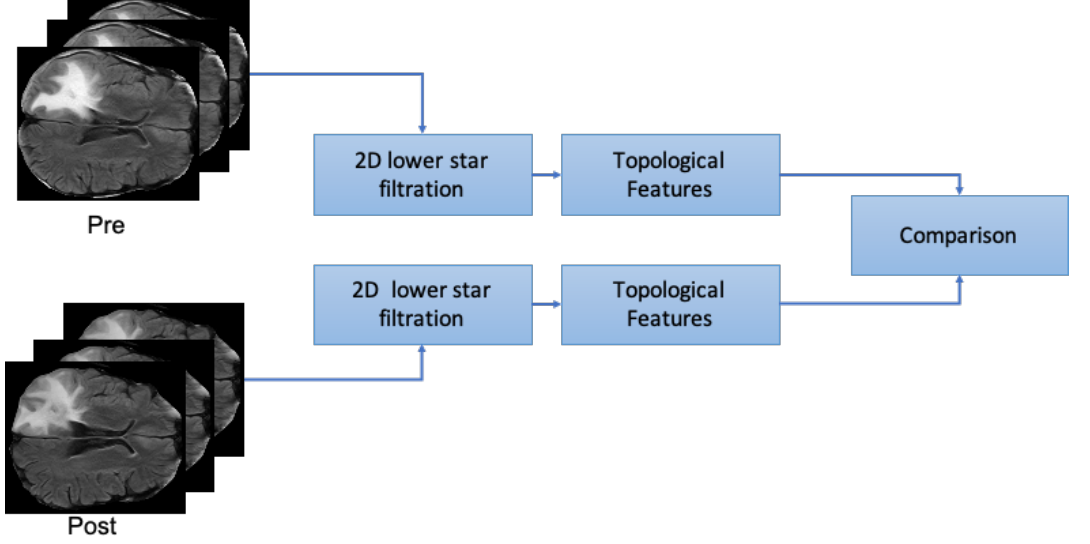
Figure 4. Flowchart depicting the main sequence of steps performed in the second experiment. The steps are documented in the text.